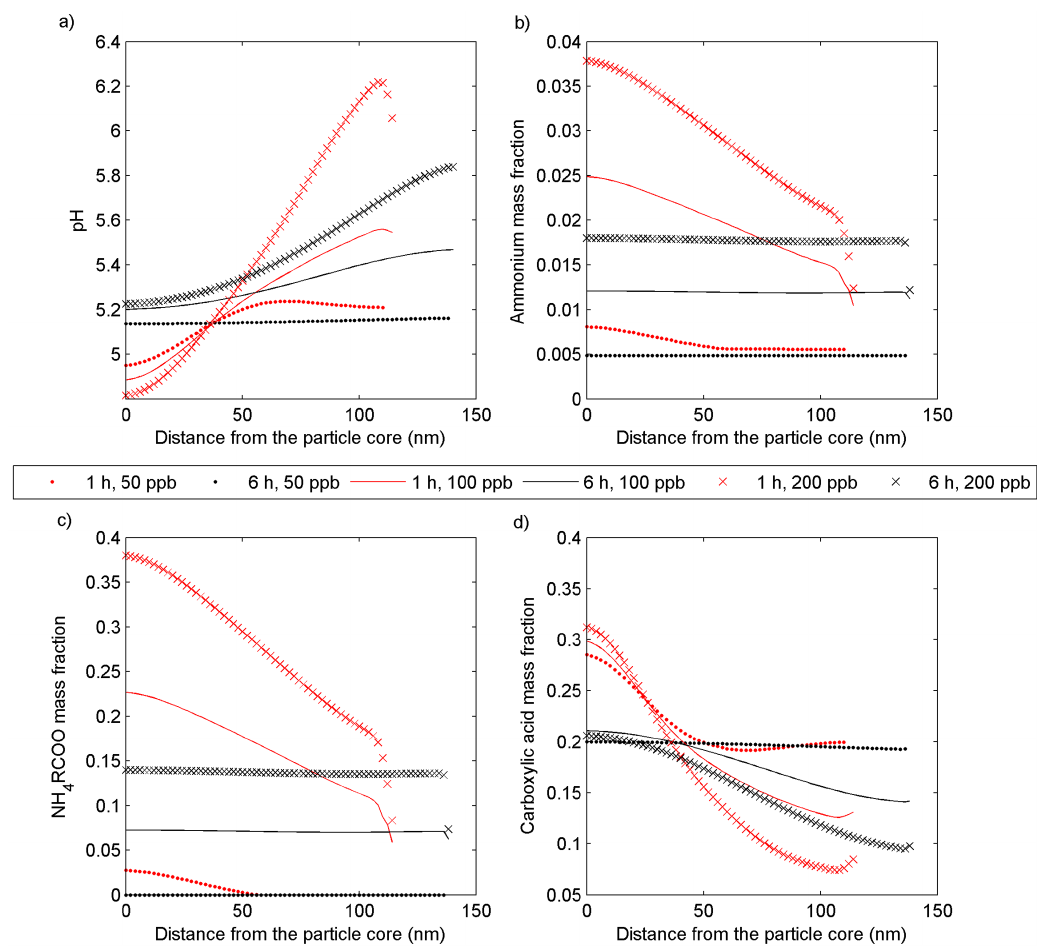
+ NH + NH Figure 11. Modelled (a) pH, (b) ammonium (NH + 3 (l) 4 in NH 4 RCOO) mass fractions, (c) NH 4 RCOO mass fractions and (d) 4 carboxylic acid (COOH + COO − ) mass fractions at different distances from the particle core for α -pinene SOA particles with a diameter of approximately 240nm after 1h and 280nm after 6h of aging. The model results are from three different simulations with an initial [NH 3 (g)] of 50, 100 or 200ppb. The SOA particles were assumed to be semi-solid with D 0 , monomer , SOA = 10 − 15 cm 2 s − 1 , D 0 , ammonium